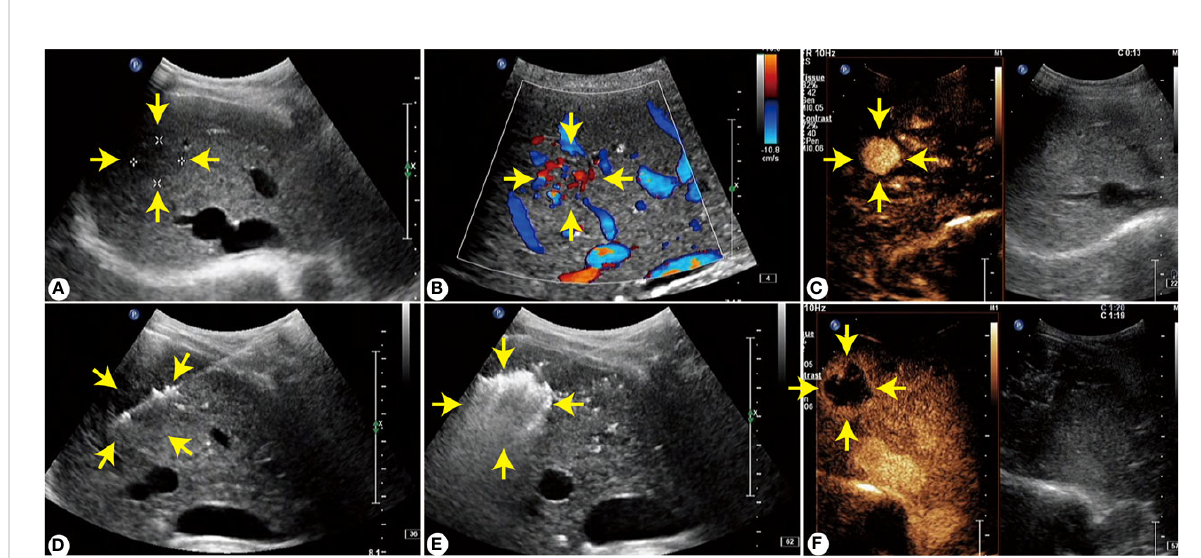
FIGURE 1 The whole process of ultrasound-guided abltion of S8 segment of FNH lesions. (A) Two-dimenstional ultrasound imagine of FNH lesions. (B) Color Doppler fl ow magine of FNH lesions. (C) FNH contrast-enhanced ultrasound images in arterial phase Cover. (D) FNH lesion ablation needle enters the proper position to start ablation. (E) The lesion is ablated until fully covered by hyperechoic echoes. (F) Contrast-enhanced ultrasound 15 minutes after ablation indicates that the lesion has no